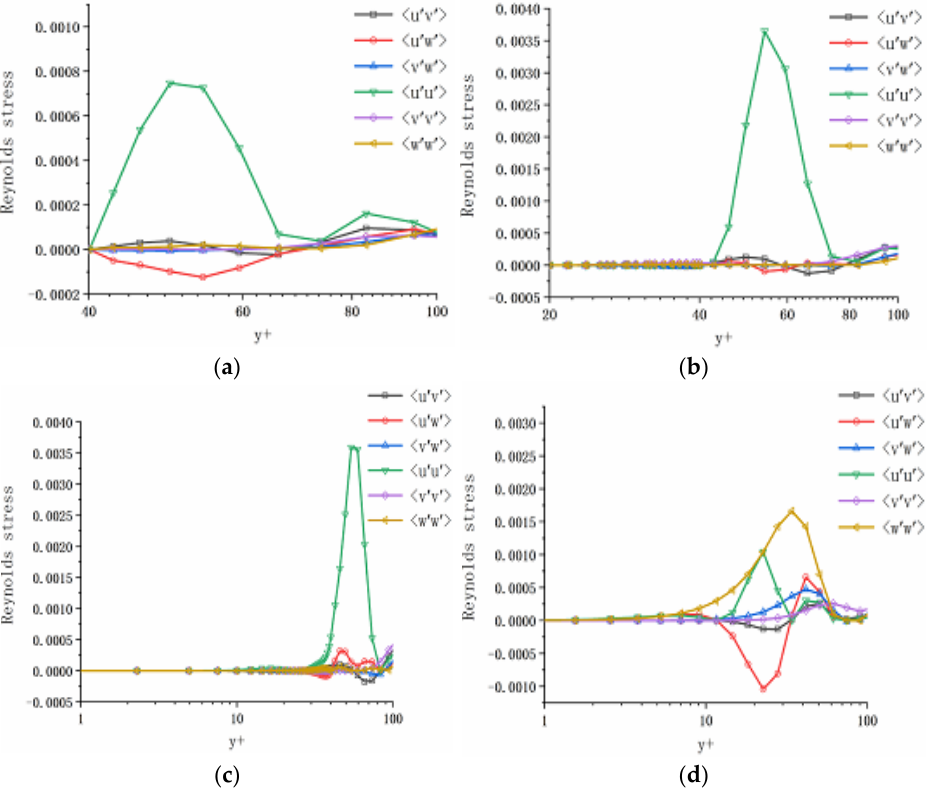
Figure 17. Distribution of Reynolds stress in triangular groove along the normal direction of the plate at 0.3Ma; ( a ) top of the groove; ( b ) middle of the groove; ( c ) bottom of the groove; ( d ) smooth